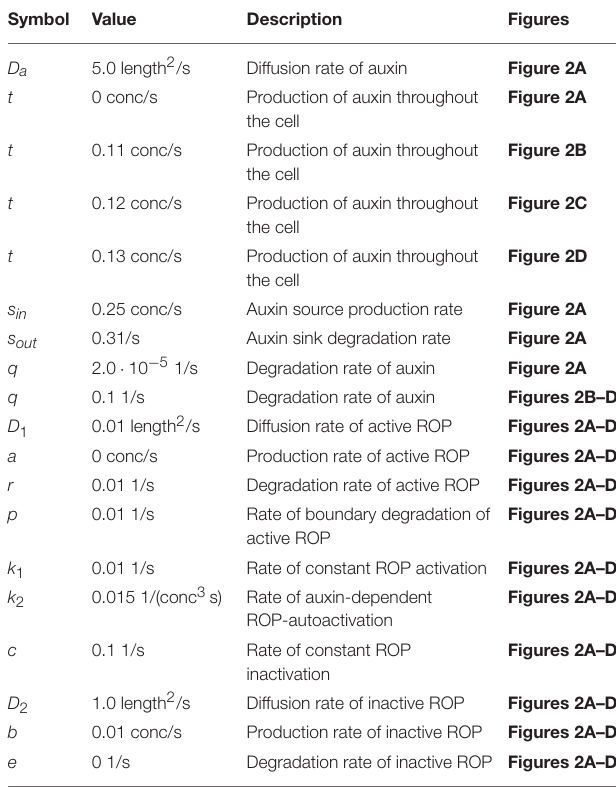
TABLE 1 | Model parameters for the ROP activation